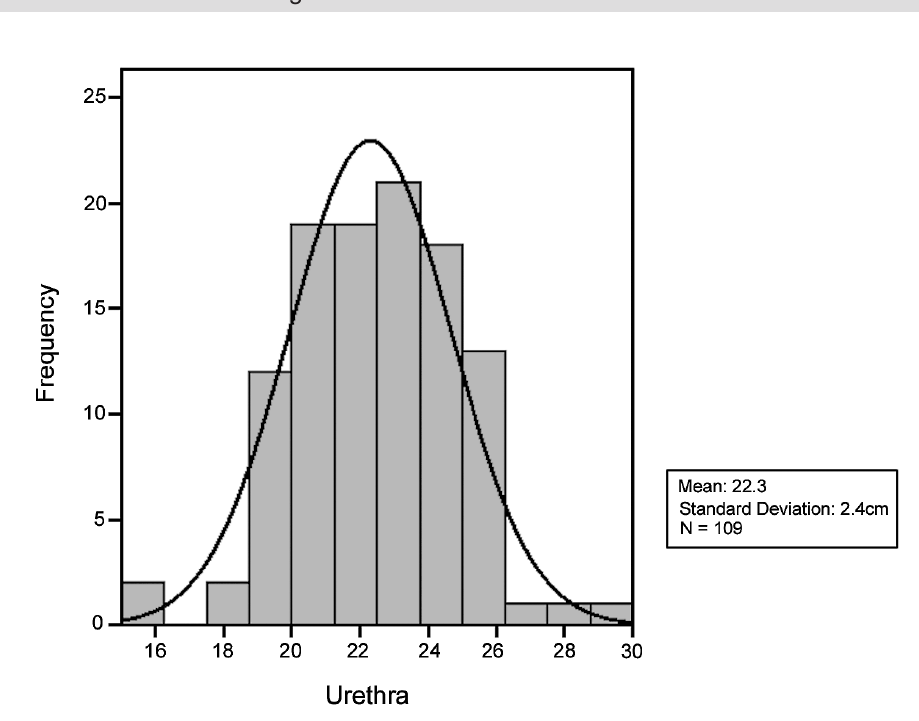
Figure 1 – Urethral length (cm) distribution.